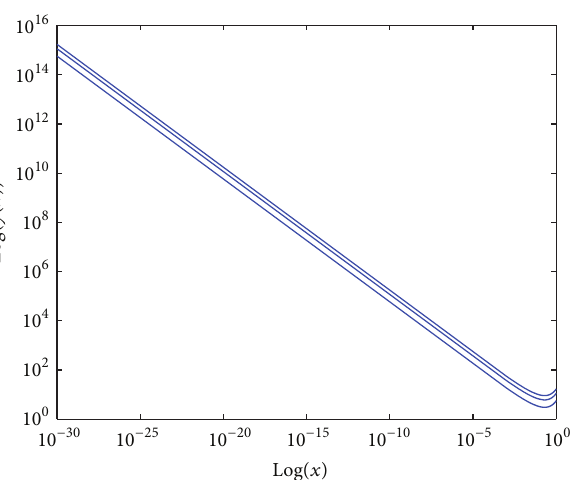
Figure 5: Solution of Example 5, 𝛽 = 1 .